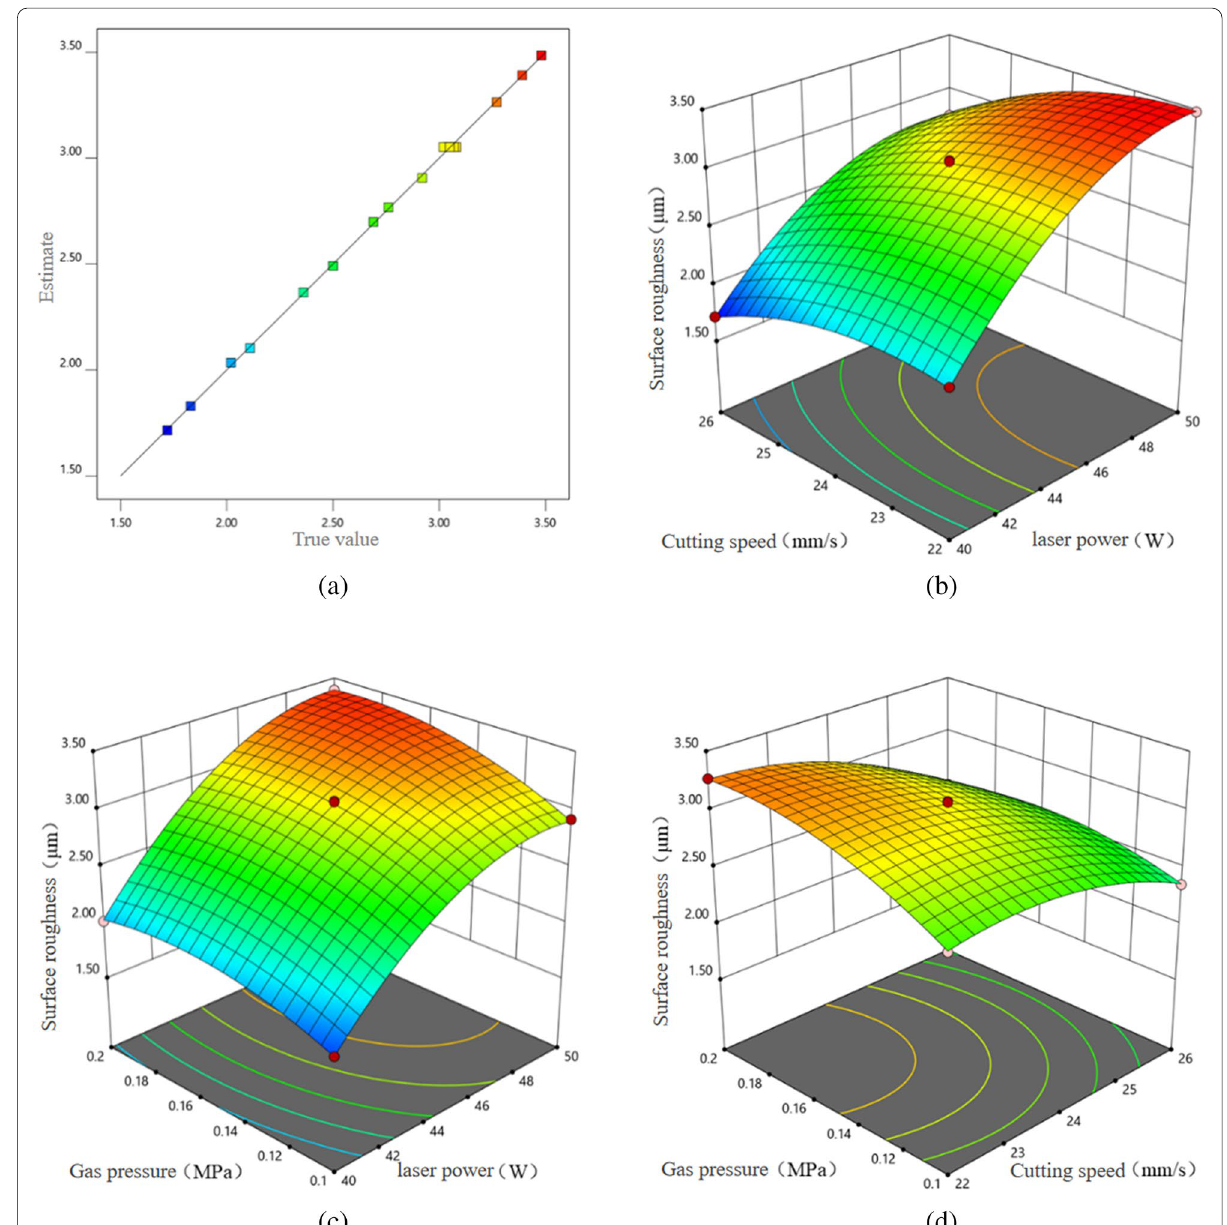
Fig.12 Response surface diagram of surface roughness of inert gas-assisted laser cutting wood. a Comparison between predicted and actual. b Interaction of laser power and cutting speed. c Interaction of laser power and gas pressure. d Interaction of cutting speed and gas